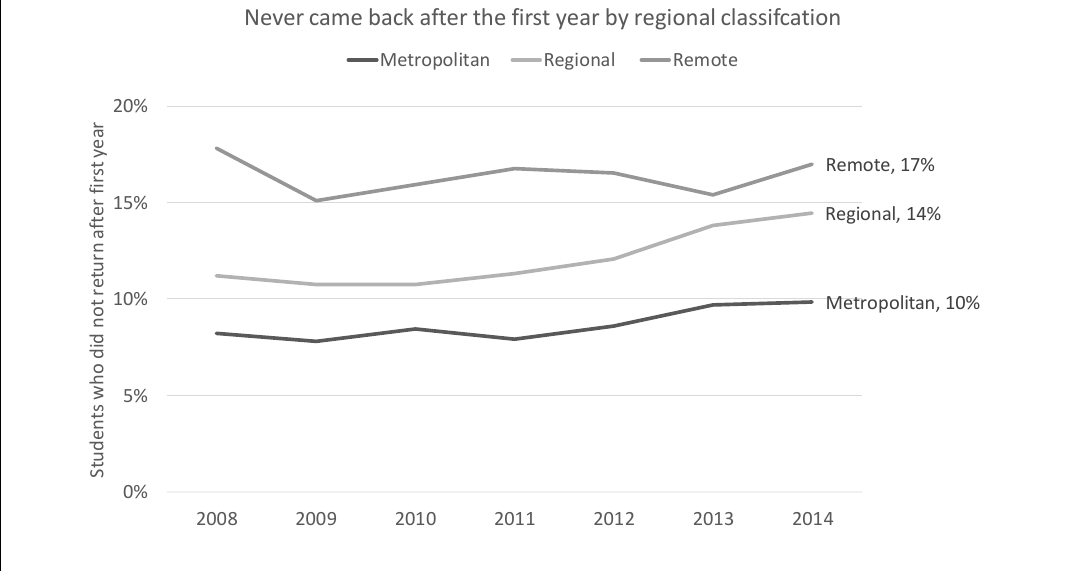
Figure 2. First-year attrition rates by regional classification (DET,